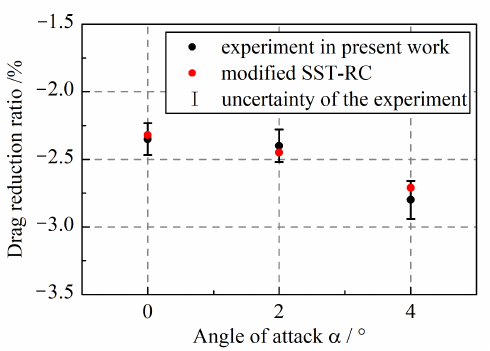
Figure 21. Comparison work of the numerical results and experimental results.